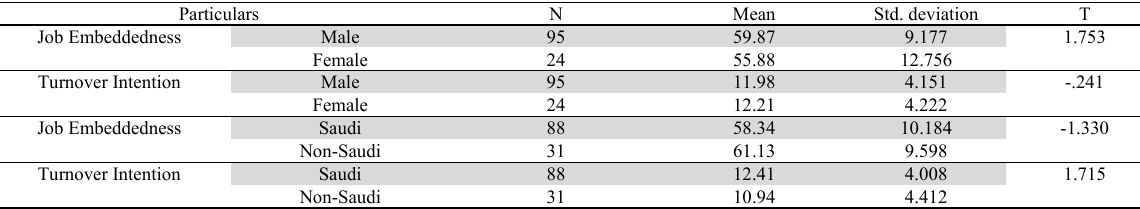
Results of t-tests